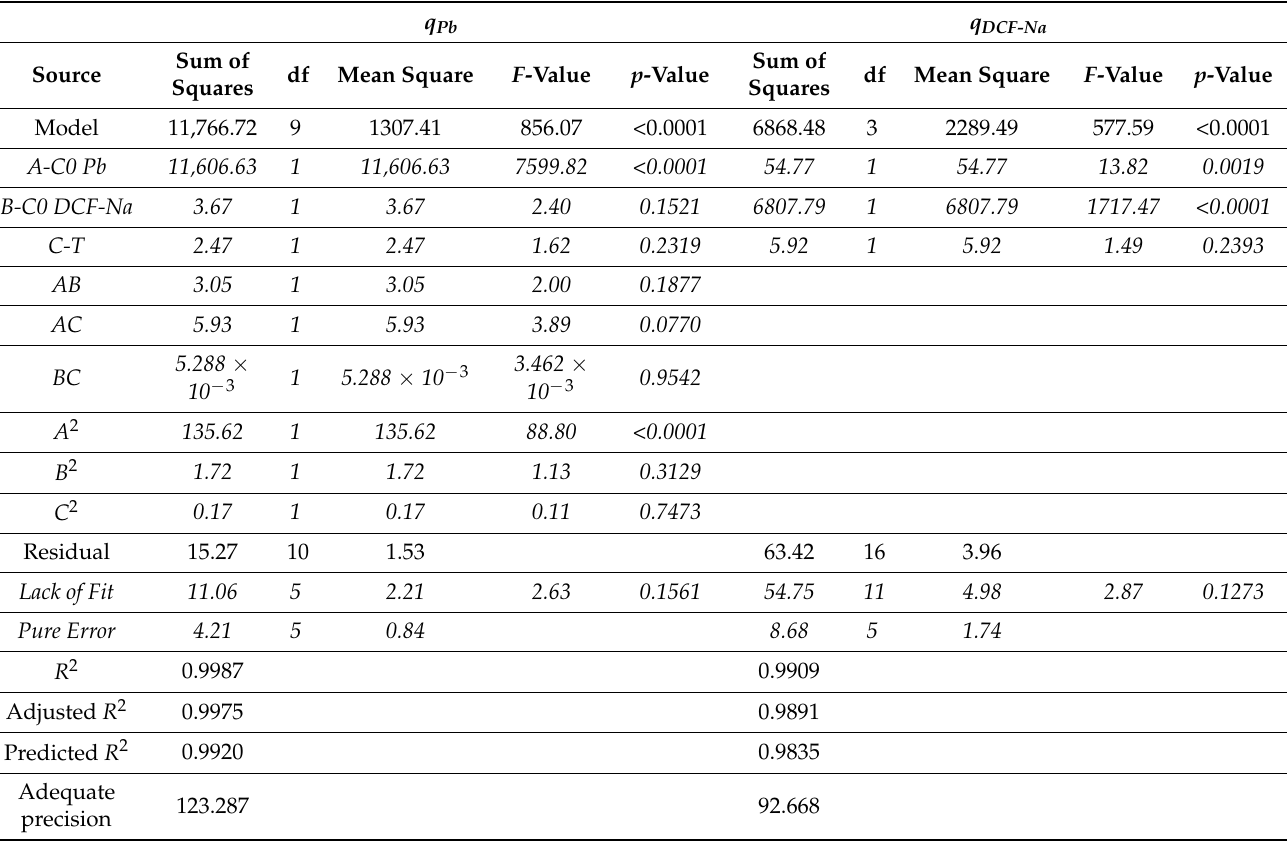
Table 6. ANOVA summary for the CCD models for the sorption of Pb 2+ ions and DCF-Na by the IS/(PEI/PMAA)c (r = 1.0) composite